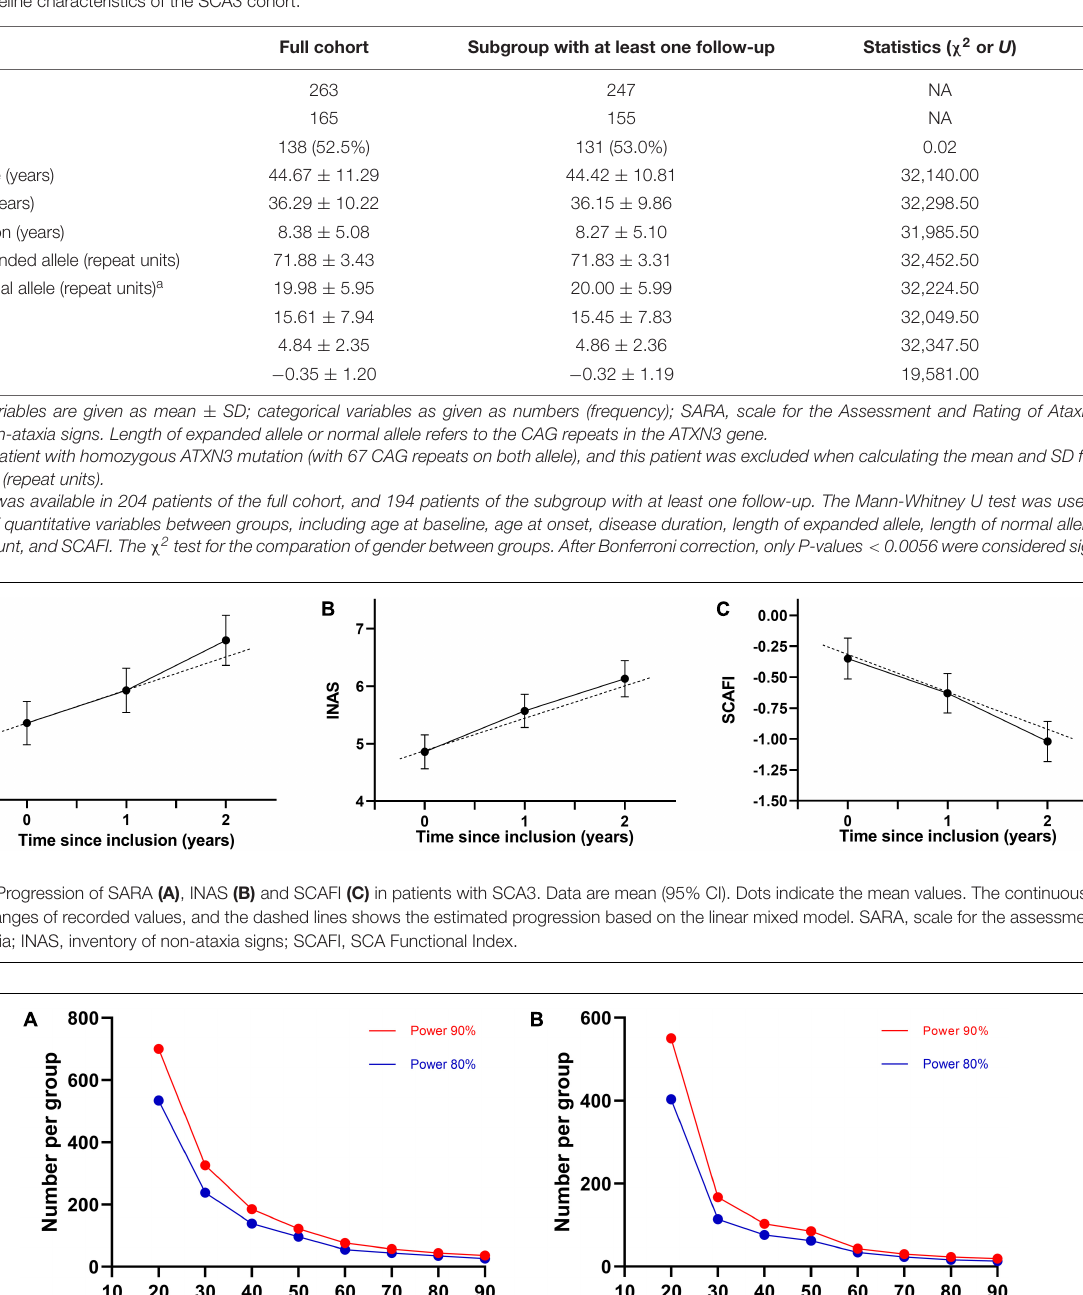
TABLE 1 | Baseline characteristics of the SCA3 cohort.